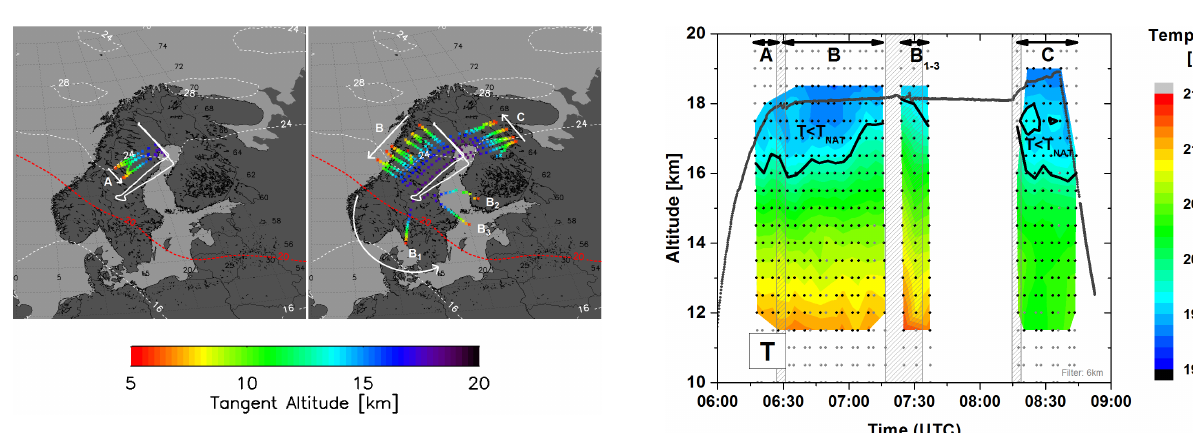
Figure 3. Tangent points associated with the MIPAS-STR measure- ments during the PSC flight on 25 January 2010 colour-coded ac- cording to altitude (asterisks). The location of the polar vortex is in- dicated by isolines of potential vorticity (dotted white lines, values in PVU) at the potential temperature level of 430K (approximately 18km) as extracted from the ECMWF ERA-Interim reanalysis. The vortex edge is indicated according to Nash et al. (1996) by the red dotted line (from Woiwode PhD thesis, 2013, with modifications).